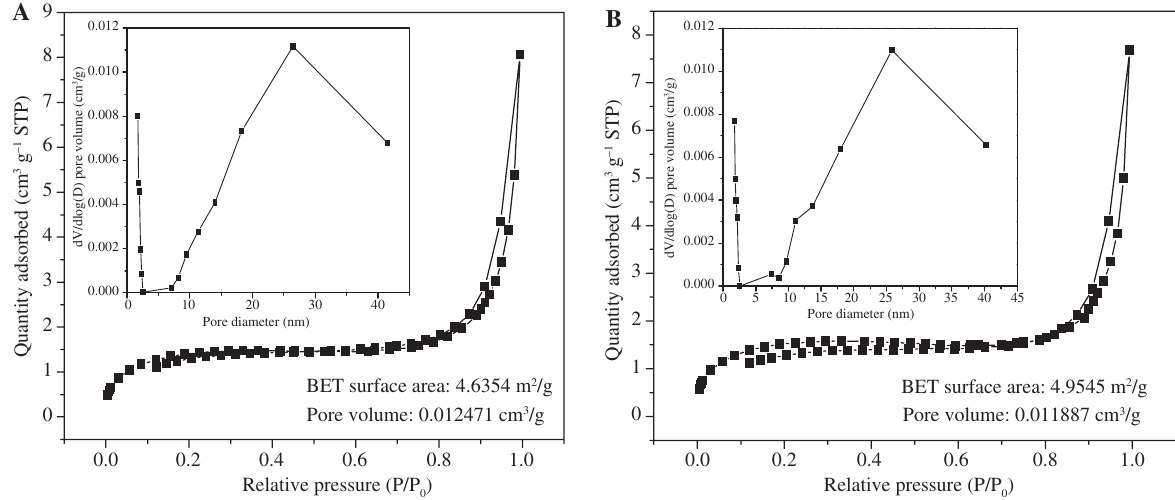
O /C (A) and Fe O /C-CAA microspheres (B). 3 4 3 4